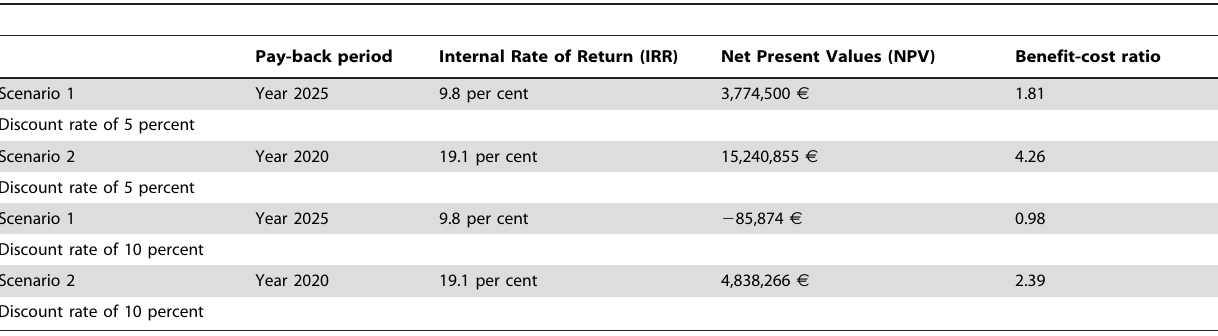
Table 4. Main financial indicators of the tsetse elimination